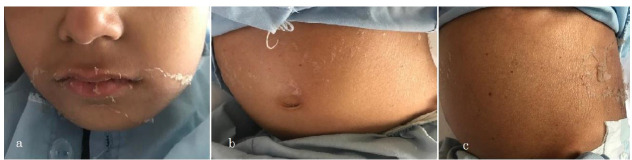
 Development of erythroderma and a macular rash within a few days of voriconazole treatment, followed by generalized exfoliation
in the face and trunk (a few days later on September 15th)